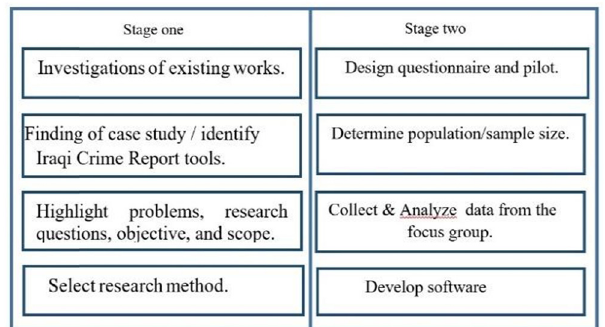
Figure 1: Process of two stages for